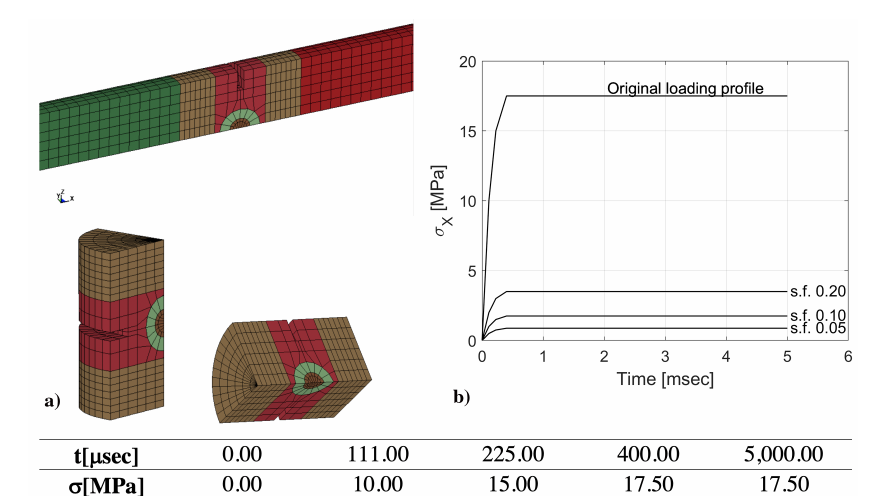
Figure 2. Finite element model used for numerical investigations on metaconcrete (a), Original and scaled loading profile (see scaling factor s.f.)